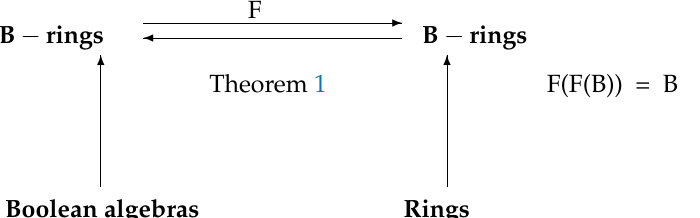
Figure 3. B–rings are structures which generalize both rings and Boolean algebras. In other words, a ring (respectively, a Boolean algebra) could be understood as a